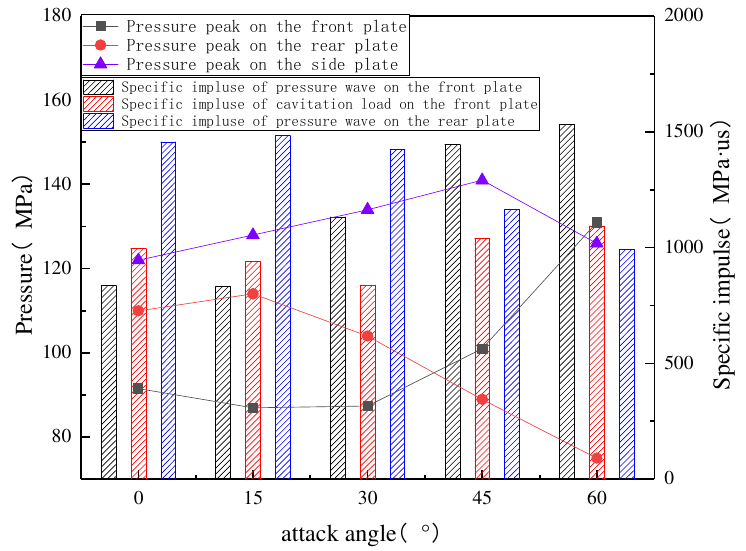
Figure 17. Peak value and specific impulse of pressure wave on each wall of the tank. Table 7. Peak value and specific impulse of initial pressure and cavitation load.